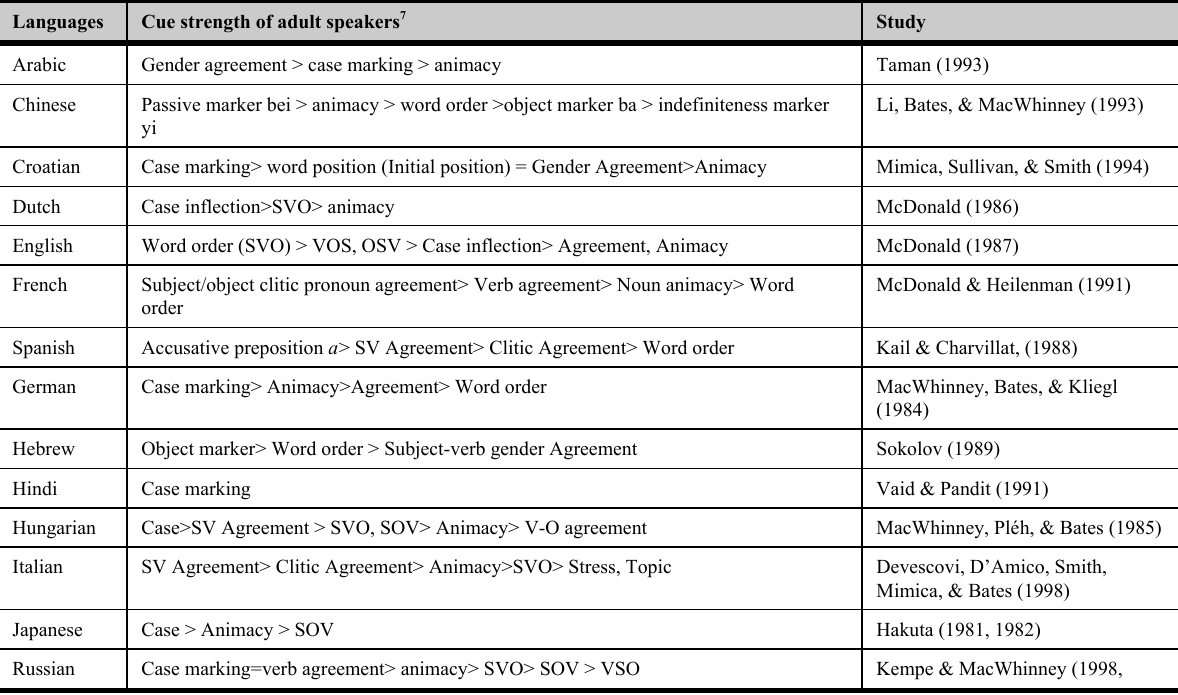
Order of Cue Strength of Adult Speakers across